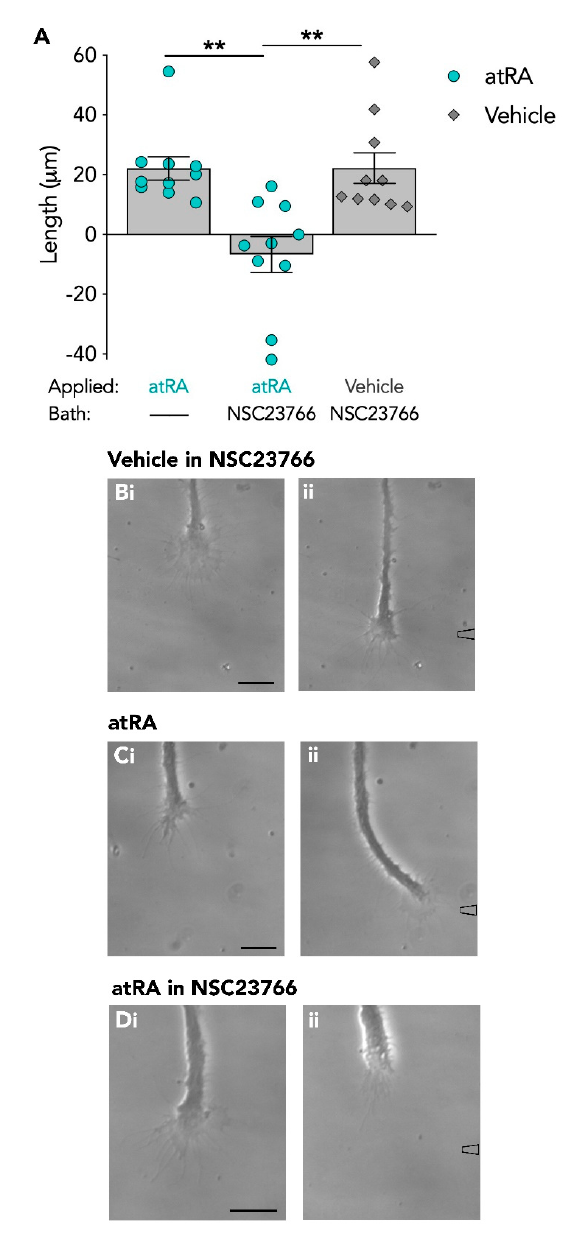
Figure 4. Inhibiting Rac switches the atRA-induced growth cone attraction to collapse and retraction. ( A ) Graph depicting the length of growth cone advancement in response to atRA (or vehicle) in the presence or absence of the Rac inhibitor, NSC23766. In the presence of the Rac inhibitor, growth cone advancement following application of atRA was inhibited, compared to all other experimental conditions (** p < 0.01). In response to application of vehicle in the presence of NSC23766, growth cones did not turn, but continued to advance ( Bi – ii ; n = 10; t = 40). ( C – D ) Example of an individual growth cone that first produced attractive growth cone turning to atRA ( Ci – ii ; t = 60), but following application of NSC23766 to the bath, later collapsed and retracted in response to atRA ( Di – ii ; t = 55). Scale bars: 15 µ